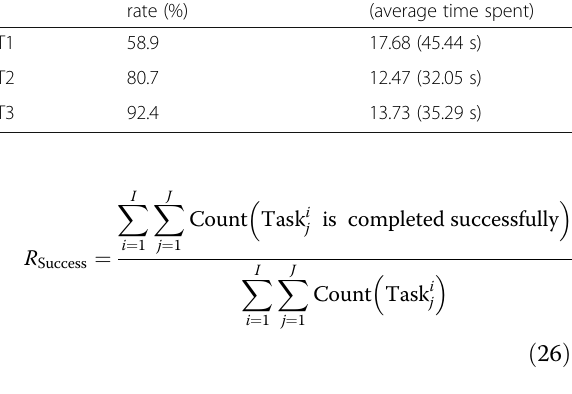
Table 5 Experimental results for different dialog strategies